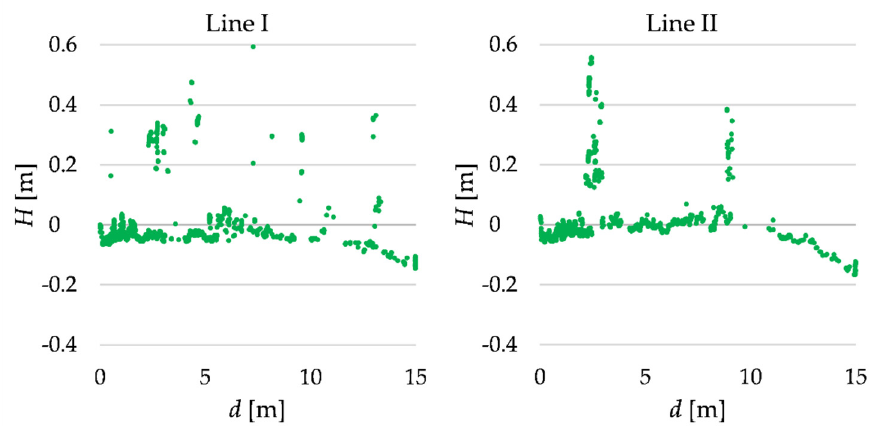
Figure 7. TLS data related to lines I and II.